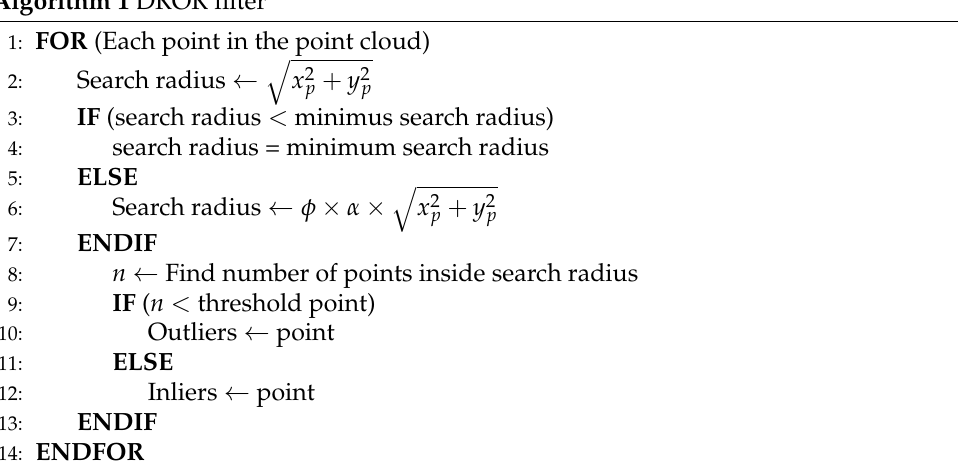
Algorithm 1 DROR